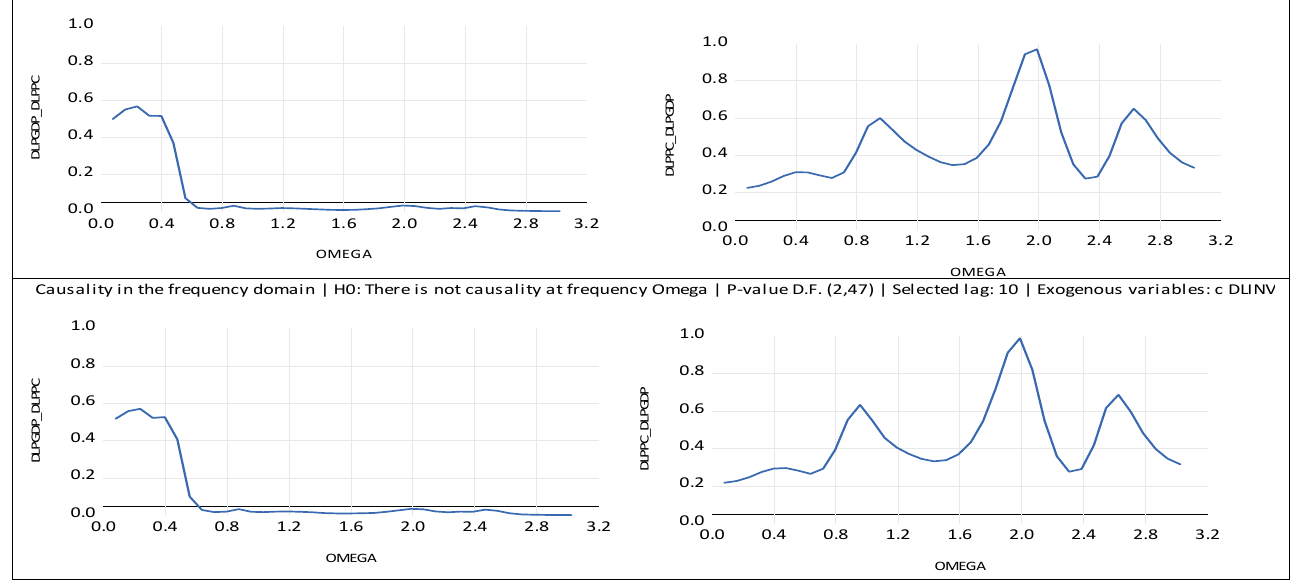
Figure 2. The unconditional and conditional on investment i.e., DLINV frequency domain causalities are reported in the upper and lower panel, respectively. Frequency is represented by omega ( ω ) on the horizontal axis, while the corresponding p -values are on the vertical axis. The label of the graph to the left of the vertical axis is in the form of ( var i − var j ) where var i is the dependent variable and var j is the independent variable. The figures on the left (right) illustrate the causality from DLPPC to DLPGDP ( DLPGDP to DLPPC ). The null hypothesis is H0: There is no causality at the frequency Omega. The black horizontal line represents 5% level of significance.